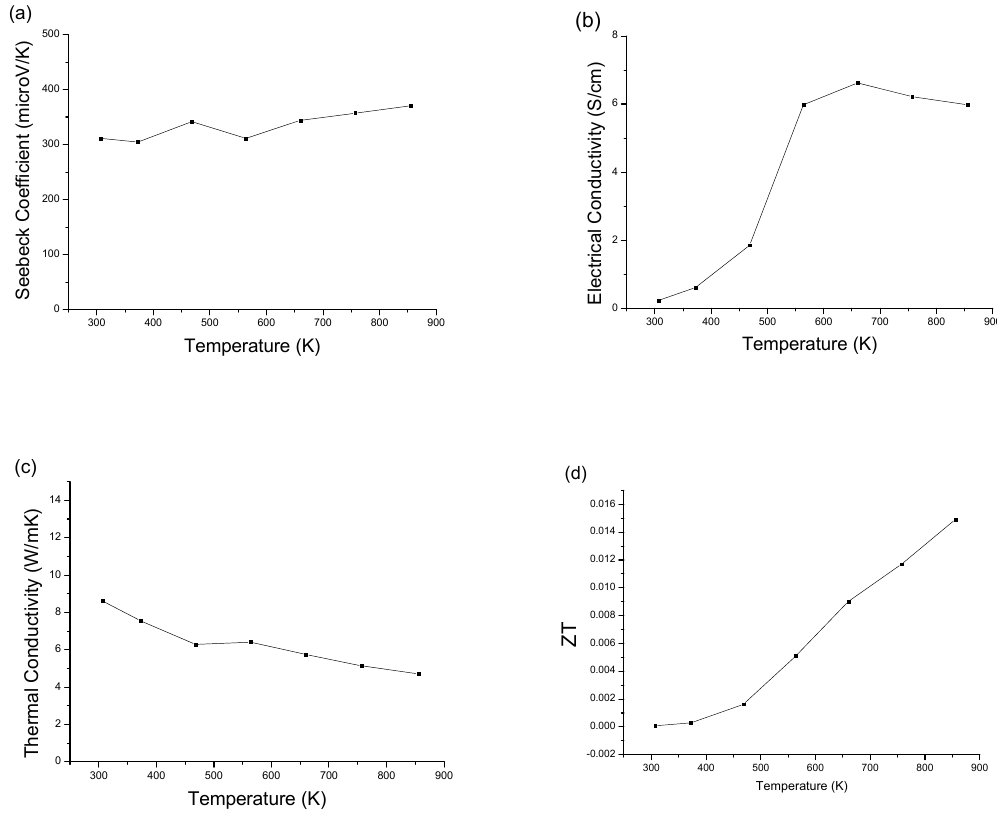
Figure 3. Variation of ( a ) Seebeck coefficient, ( b ) electrical conductivity, ( c ) thermal conductivity and ( d ) ZT with temperature for two at % Al excess (S1 2 ) sample.